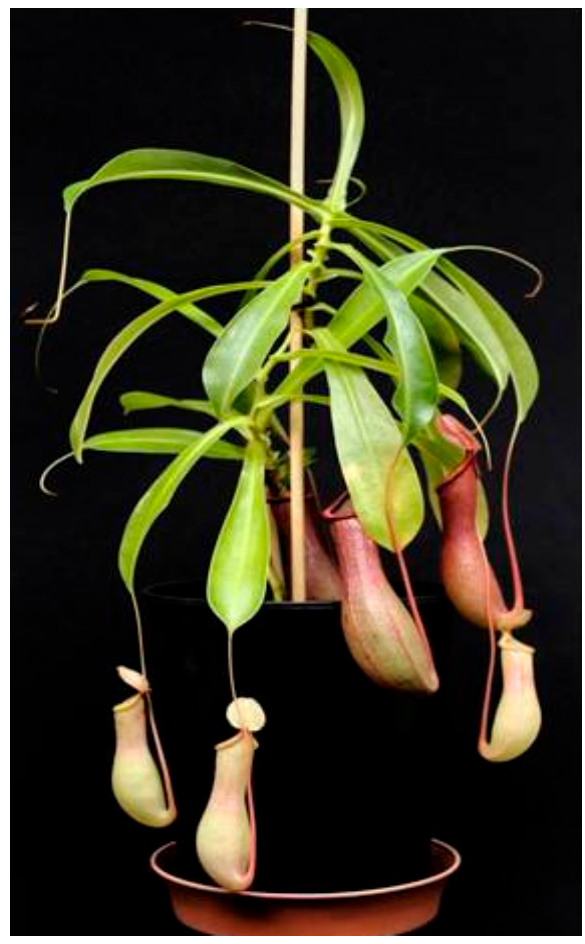
Figure 1. Nepenthes x ventrata . A natural hybrid of N. ventricosa and N. alata . Copyright © A. Rahman-Soad. (A)biotic challenges include the attack of herbivorous insects. Interestingly, there are only a very few observations and studies published concerning the attack of insects on tissues of carnivorous pitcher plants. Recently, lepidopteran herbivory was described for some species of the new world pitcher plant Sarracenia [25,26]. There is only one inves- tigation showing that N. bicalcarata plants are attacked by an insect, the weevil Alcidodes spec . [27]. Another study shows that in N. gracilis red pitchers experience less herbivory than green ones [28]. To the best of our knowledge, no other studies have been published yet that focus on herbivore damage in Nepenthes . Obviously, the carnivorous syndrome obtained much more attention. However, herbivory on Nepenthes tissue is obviously